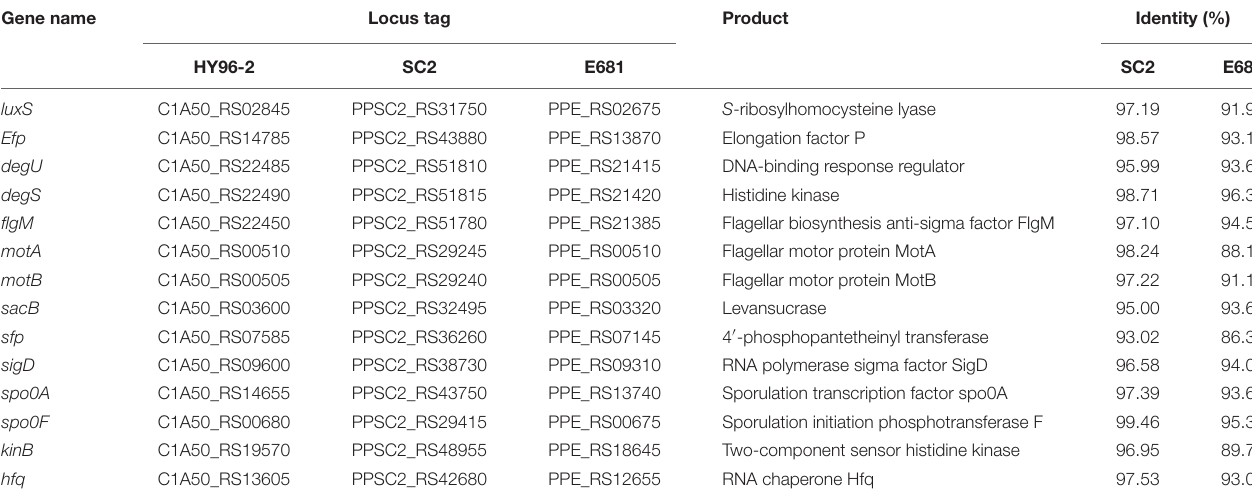
FIGURE 5 | Co-linearity results for strain HY96-2 and the seven other P. polymyxa strains. The purple dots represent the forward alignment of the two genome sequences, and the blue dots represent the reverse alignment of the corresponding segments. TABLE 3 | Comparison of core genes involved in biofilm formation in strain HY96-2, as well as in strains SC2 and E681 (sequence similarity is expressed as a percentage of the nucleotide